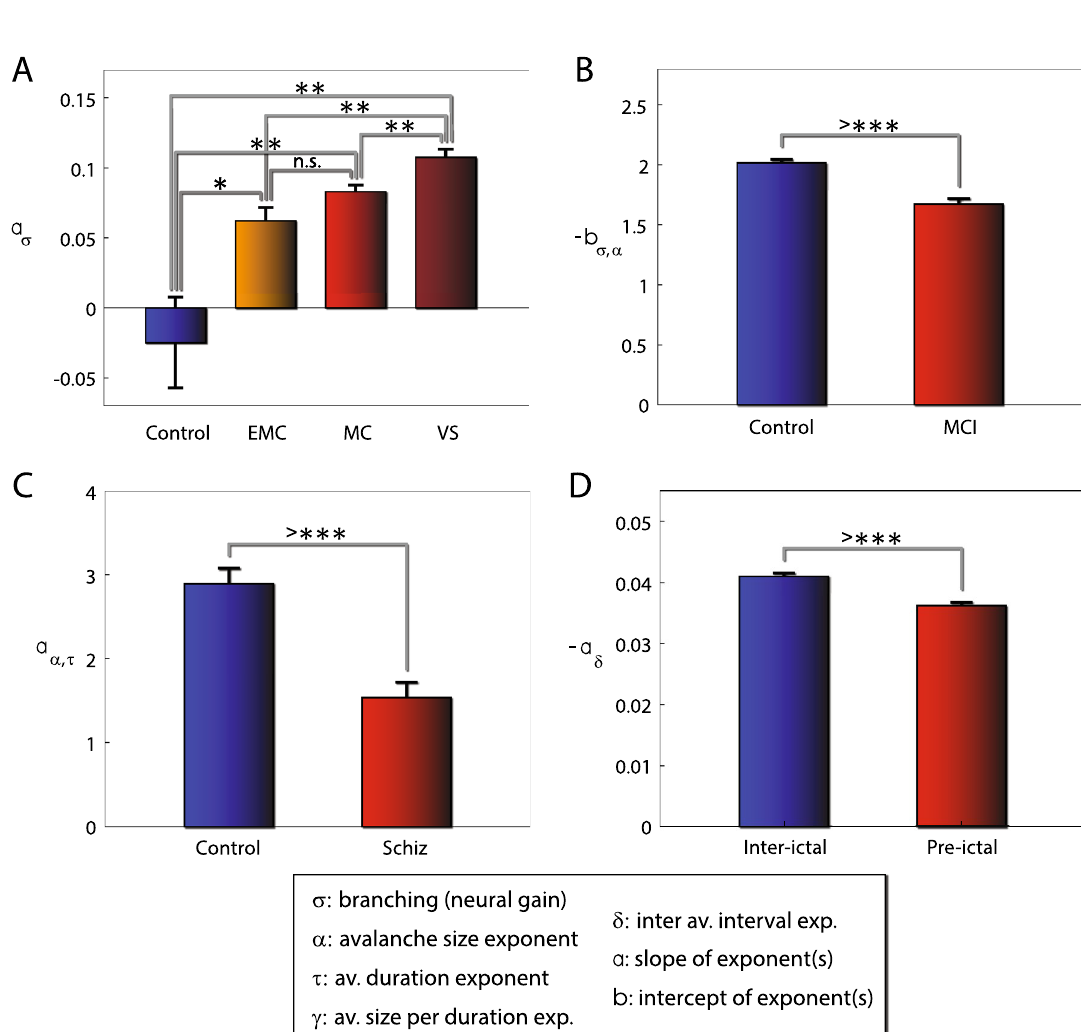
Figure 3. MsCr measures are sensitive to compromised capacity for information processing. The most significant MsCr features for each of the analyzed data sets. ( A ) The time dependent behavior of the neural gain parameter σ differentiates between control subjects and DOC patients and between vegetative state (VS) and minimally conscious (MC) subjects. MsCr measures were derived from high density EEG collected during an auditory task. ( B ) The slope of the σ/α curve a σ , α , derived from joint MEG/EEG collected during an attention task is attenuated in MCI patients. This curve describes the time dependent relationship between the neural gain parameter σ, and the exponent α of the avalanche size distribution. ( C ) The slope of the α δ curve a α , δ , derived from resting state MEG is attenuated participants with schizophrenia. This curve describes the time dependent relationship between the exponent α of the avalanche size distribution, and the exponent δ, of the inter-avalanche interval distribution (IAI). ( D ) The slope of the δ curve a δ , derived from resting state EEG is attenuated during pre-ictal activity. This curve describes the time dependent behavior of the IAI